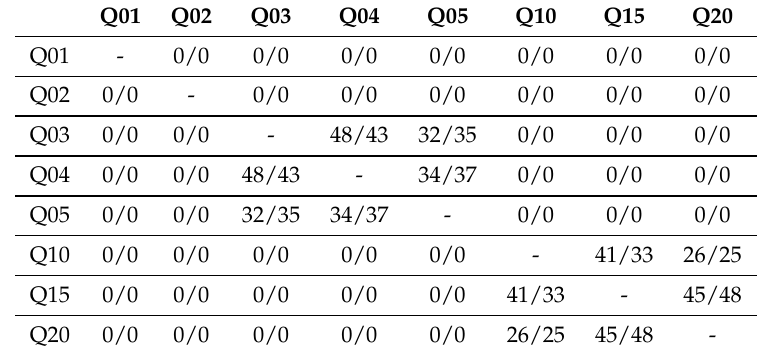
Table 15. Test results for similar Word documents with LZJD (signature comparison/file